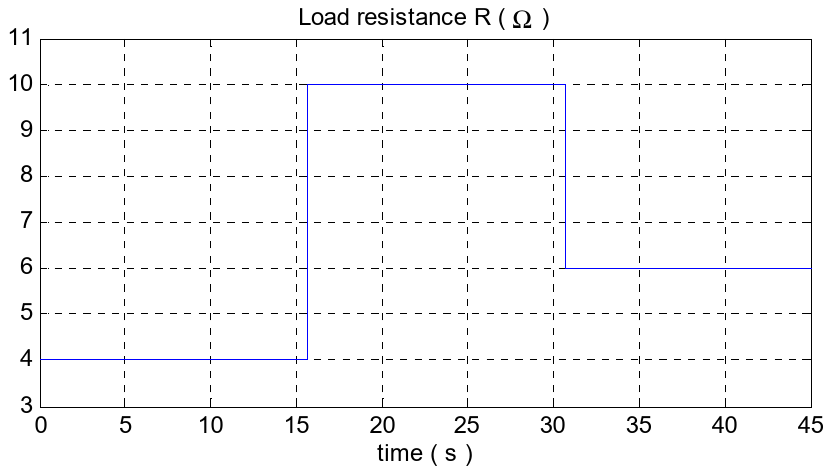
Figure 22. Programmed profile of the load resistance.